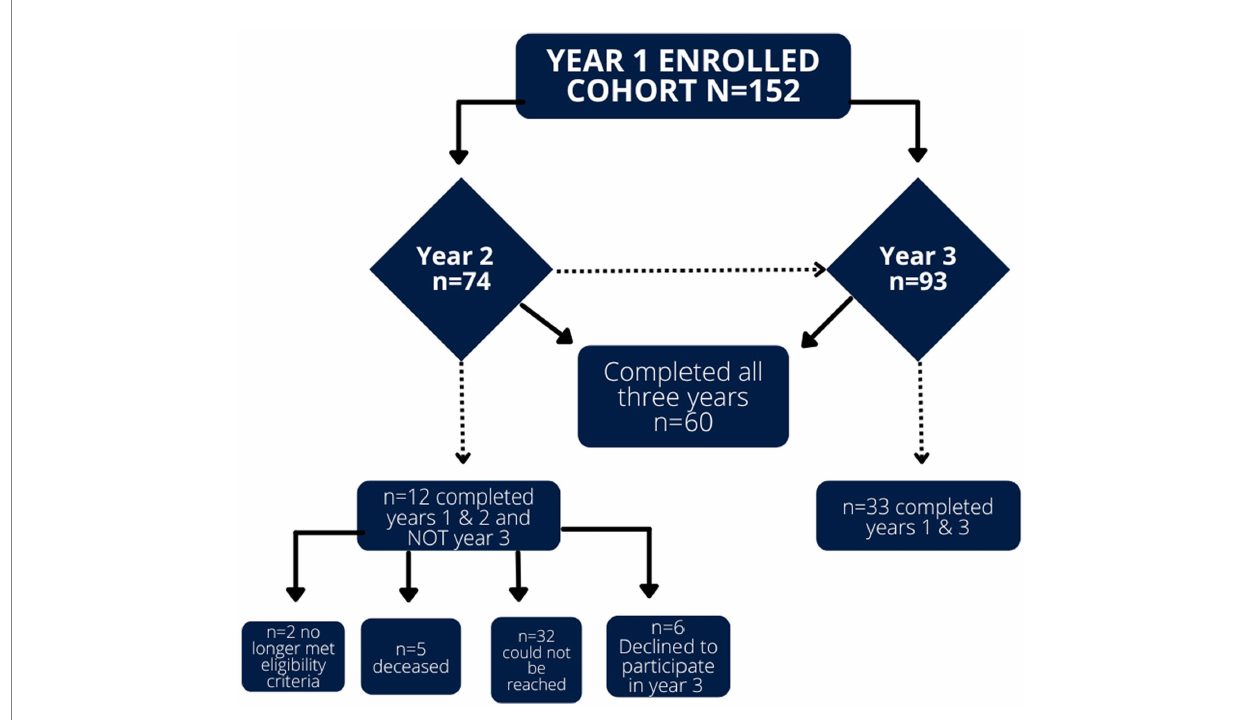
FIGURE 1 Retention and reporting for cohort study participants across the three separate time